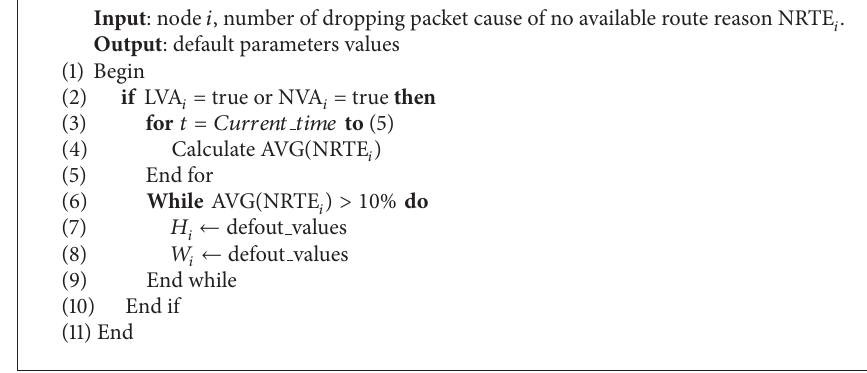
Algorithm 2: OLSR-VA Default adaptation function( 𝑖 , NRTE 𝑖 ).